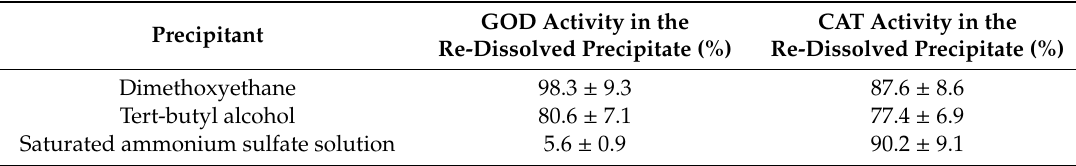
Table 1. E ff ect of the precipitant agent on the activities of glucose-oxidase (GOD) and catalase (CAT) after re-dissolving the